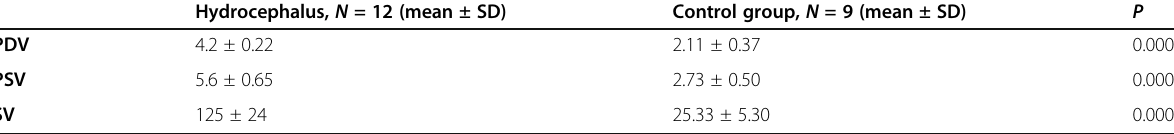
Table 4 CSF flow parameters in patient with hydrocephalus relative to control group